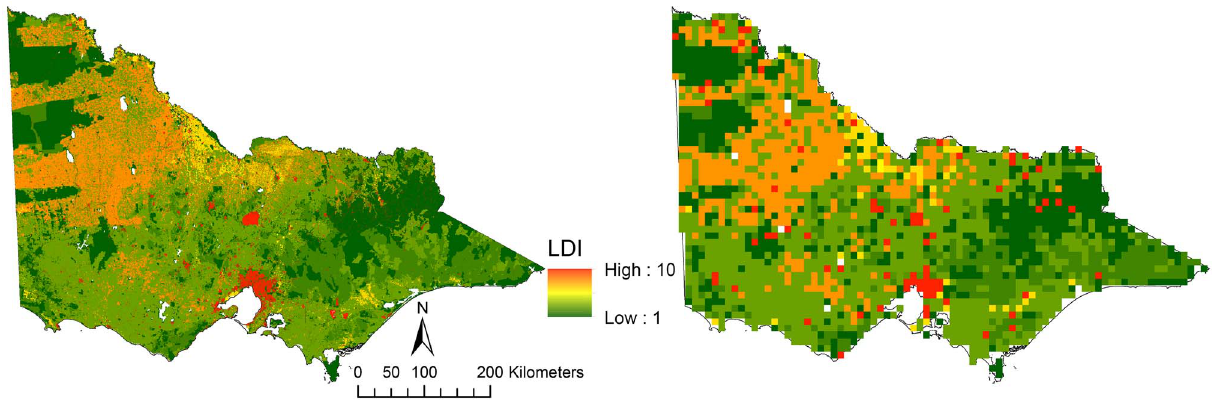
Figure 3. An example of the differences in resolution identified when working in relatively small study areas. The left hand image is the Landscape Development Intensity index (LDI) at a 30-m resolution while the image on the right is the LDI at a 10-km resolution. The accuracy of supervised classifications can be affected by the spatial resolution of the input images and as such we developed models at both resolutions. classification. The steps involved are outlined in orange in Figure 1. All sampling points that were found to contain missing data were removed prior to analysis, resulting in n =9,958 (30-m data) and n =406 (10-km data) for the two sets of data points. For the 30-m data, three 1000-point subsamples were taken for initial statistical analysis, while all data points were used for the 10-km dataset.